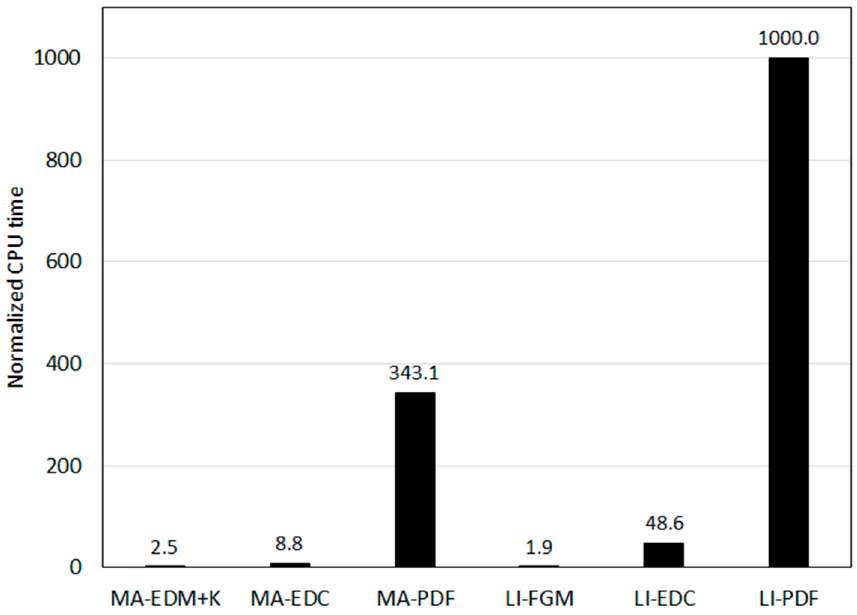
Figure 16. Comparison of the CPU times for the same number of iterations.